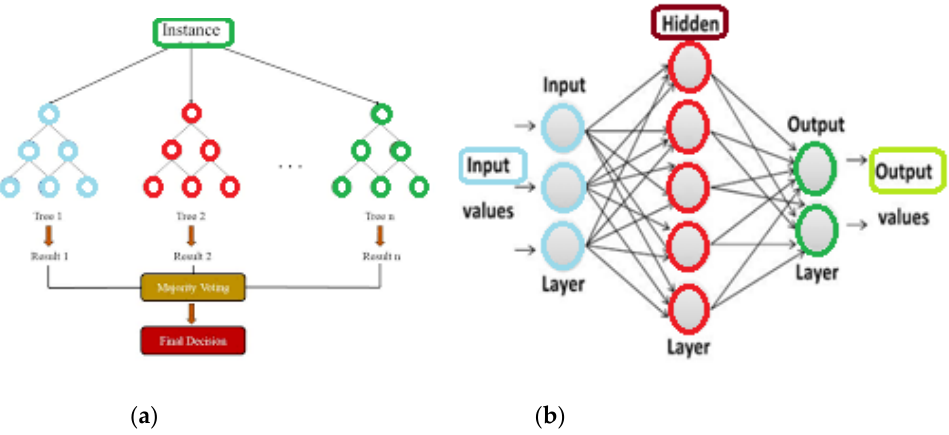
Figure 2. ( a ) Gradient Boosting structure and ( b ) MultiLayer Perceptron Figure 2. (a) Gradient Boosting structure and (b) MultiLayer Perceptron structure.